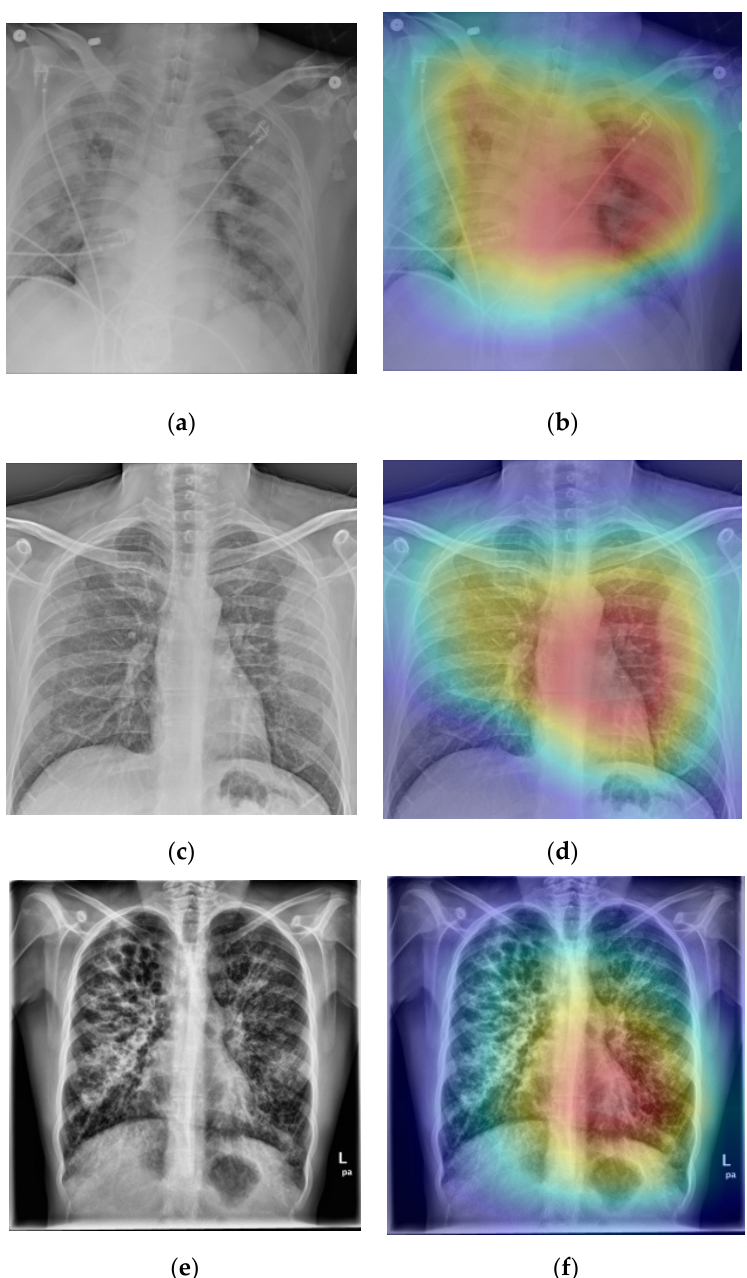
Figure 12. Grad-CAM of some COVID-19 test images: ( a , c , e ) show the original and preprocessed images; ( b , d , f ) show their corresponding heatmaps.